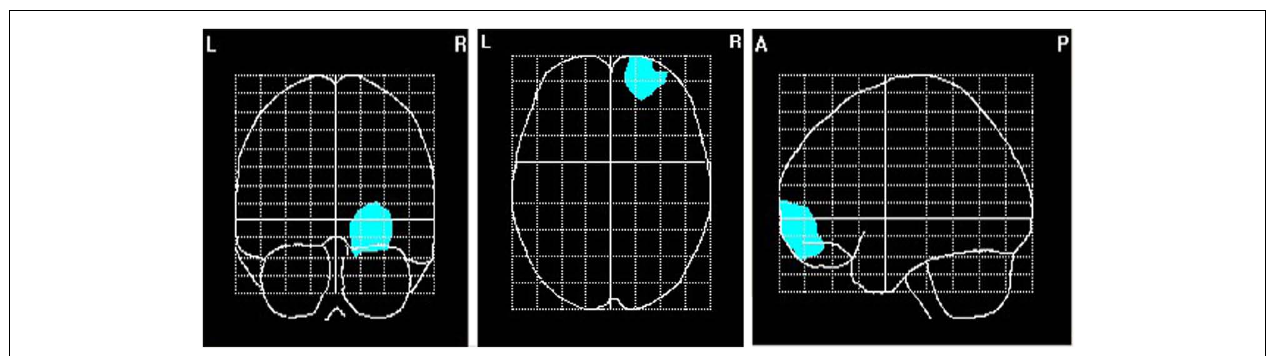
FIGURE 7 |Area of primary current density values of alpha correlating significantly with the affiliation motive. N = 70; voxels within the right ventromedial PFC that were significant at p <